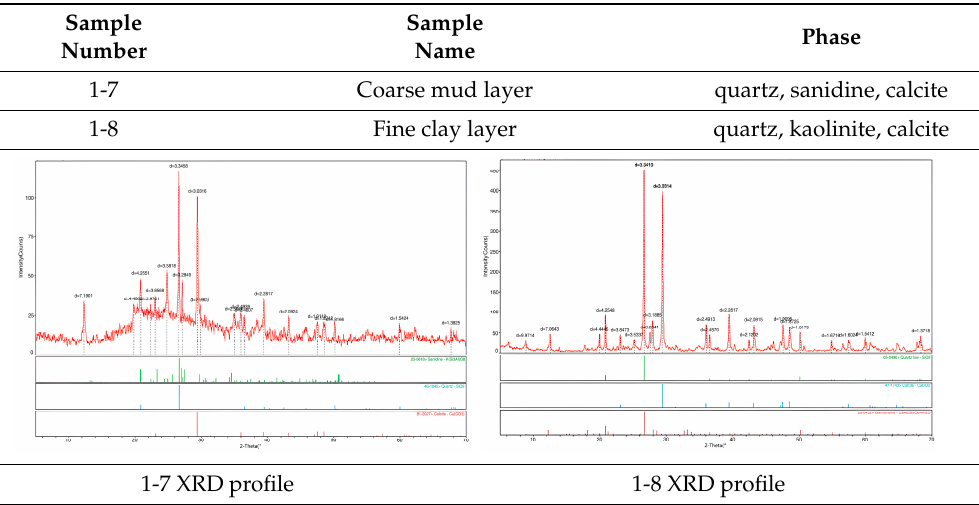
Table 4. Statue No.CS1, Sage Mother Hall: XRD analyses results.